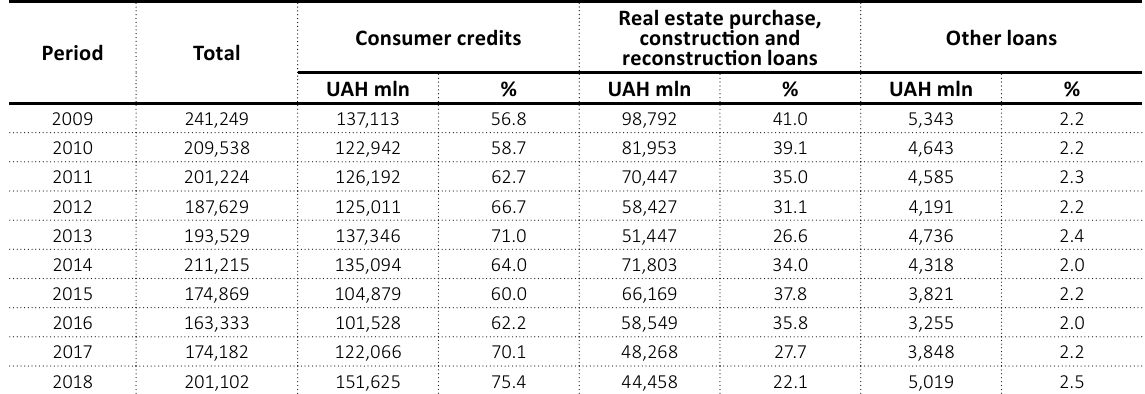
Table 4. Dynamics of the government debt of Ukraine, UAH